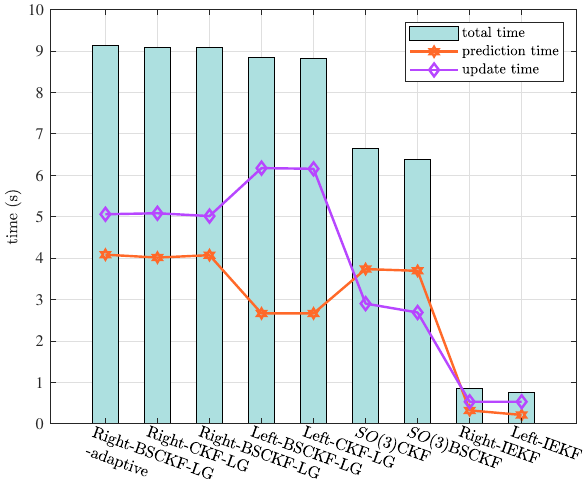
Figure 7. Execution times of different